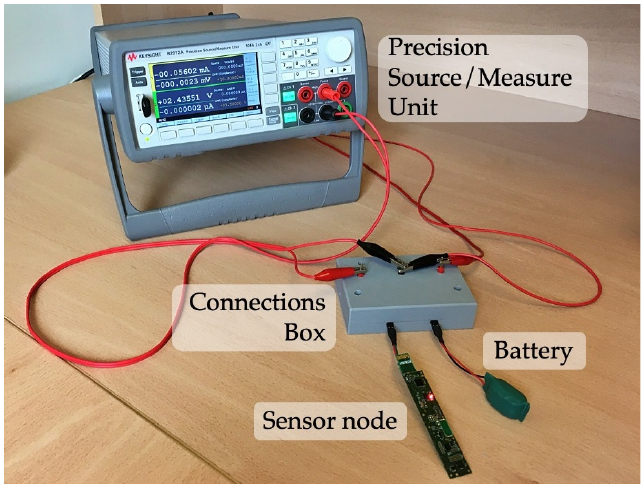
Figure 12. Experimental platform built for tests.